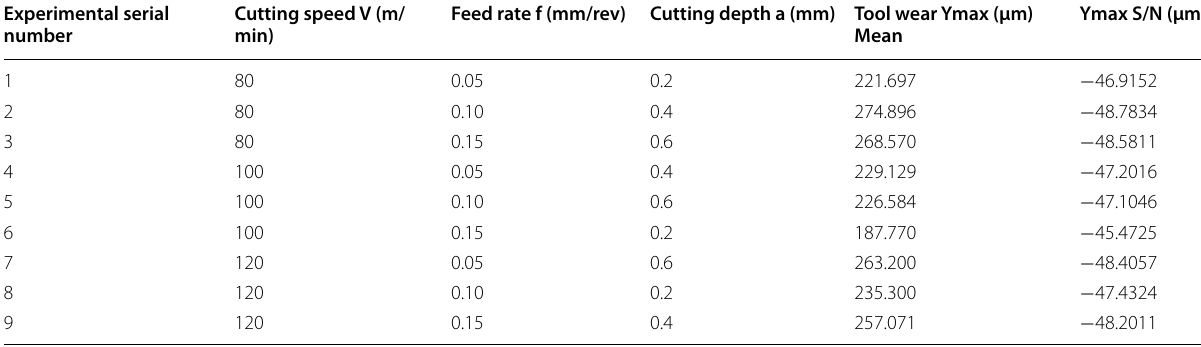
Table 7 Experimental results for wear of tool insert and S/N ratio Experimental serial number